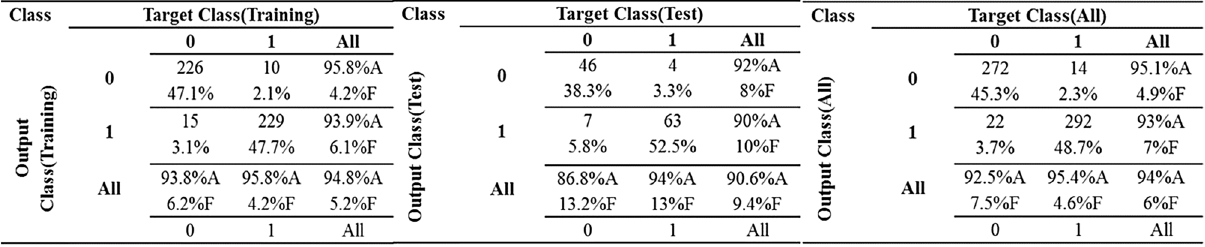
Figure 4. The confusion matrix of RBFNN neural